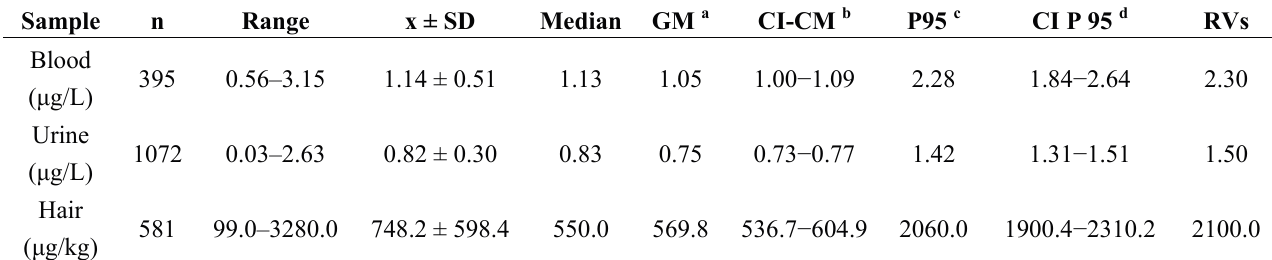
Table 1. Mercury levels in children’s blood, urine, and hair.